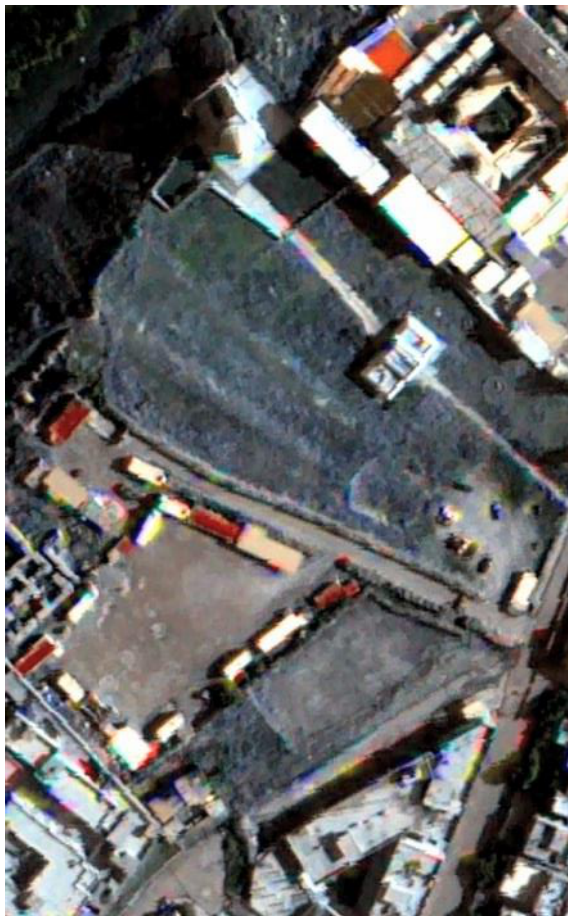
Figure 5. Mosque and sacred place of al-Nabi Sheet before the events